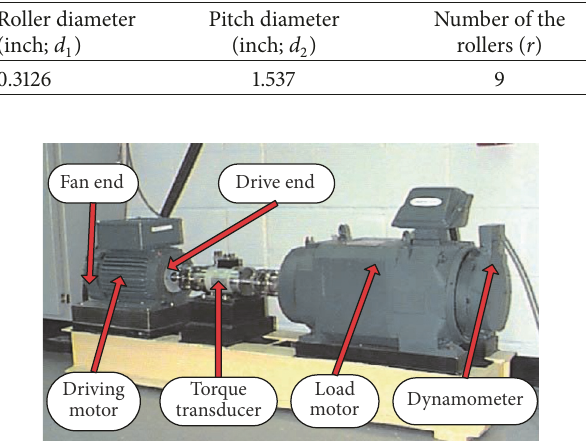
Table 1: Physical dimensions of the tested rolling bearing.